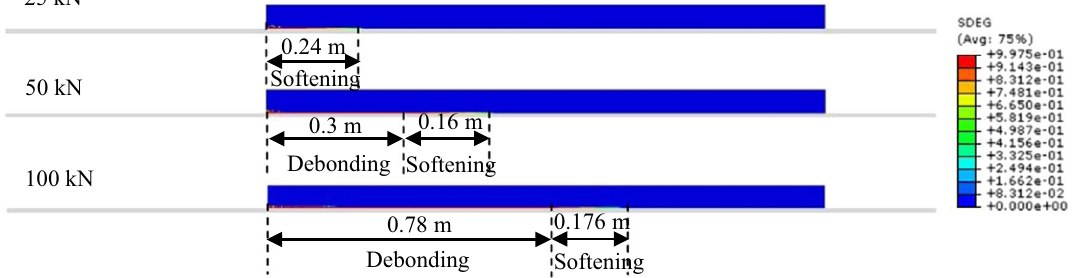
Fig. 15 Debonding and softening around rockbolt under different load level (SDEG, Scalar Stiffness